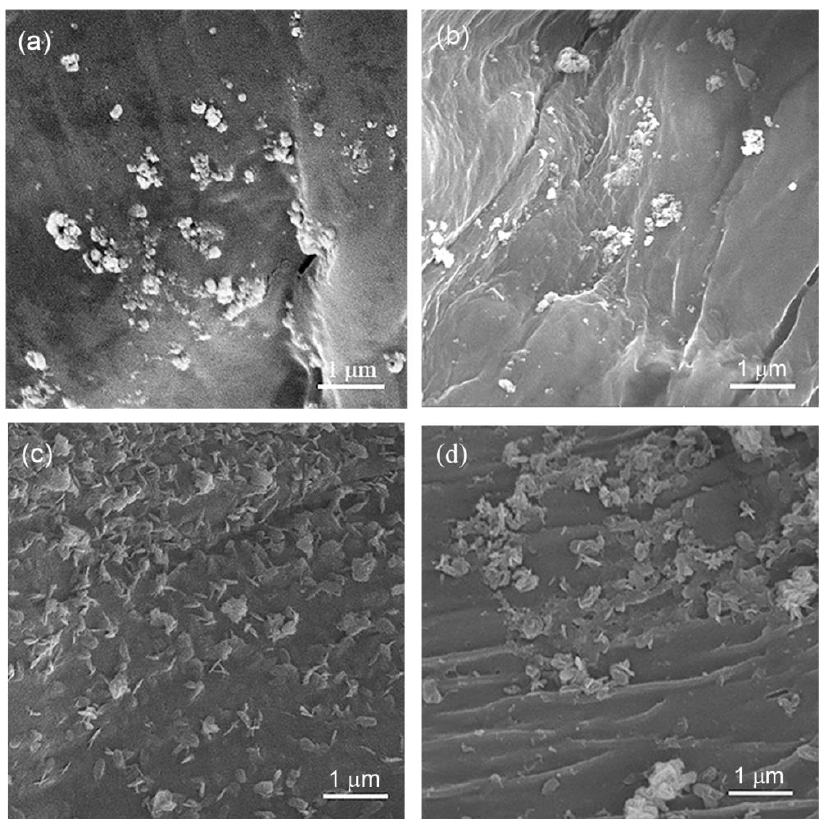
Figure 3. FESEM images of nanocomposites: ( a ) CCP-CHT1-Cu10-AA; ( b ) CCP-CHT2-Cu10-AA;